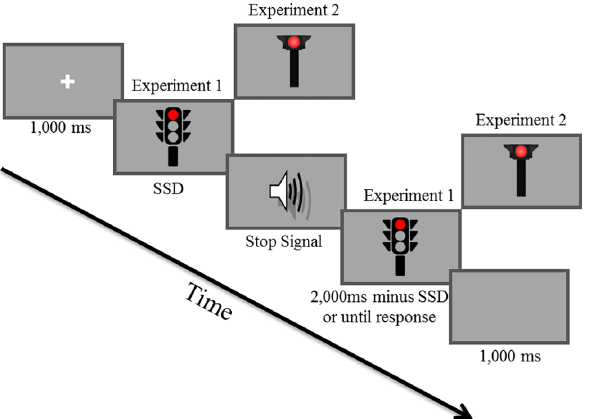
Fig 1. Example of a red traffic light stop-signal trial. In both experiments, each trial started with a 1,000 ms fixation (a white plus sign at the center of a gray screen). Following this, a visual go stimulus appeared (i.e., picture of red, green, or black (the latter only in Experiment 2) traffic light that appeared randomly and in equal proportions). In no- stop-signal trials, the go stimulus stayed in view for 2,000 ms or until a key press. In stop-signal trials, an auditory tone was presented shortly after the appearance of the go-signal. The duration between the go- and stop-signal (SSD; stop- signal delay) was subjected to a tracking procedure that was applied separately for each type of stimulus (red or green traffic light). Each trial ended with a 1,000 ms inter-trial interval (gray screen). Examples of a red light stimuli are presented from Experiment 1 (3-aspects traffic light) and Experiment 2 (1-aspect traffic